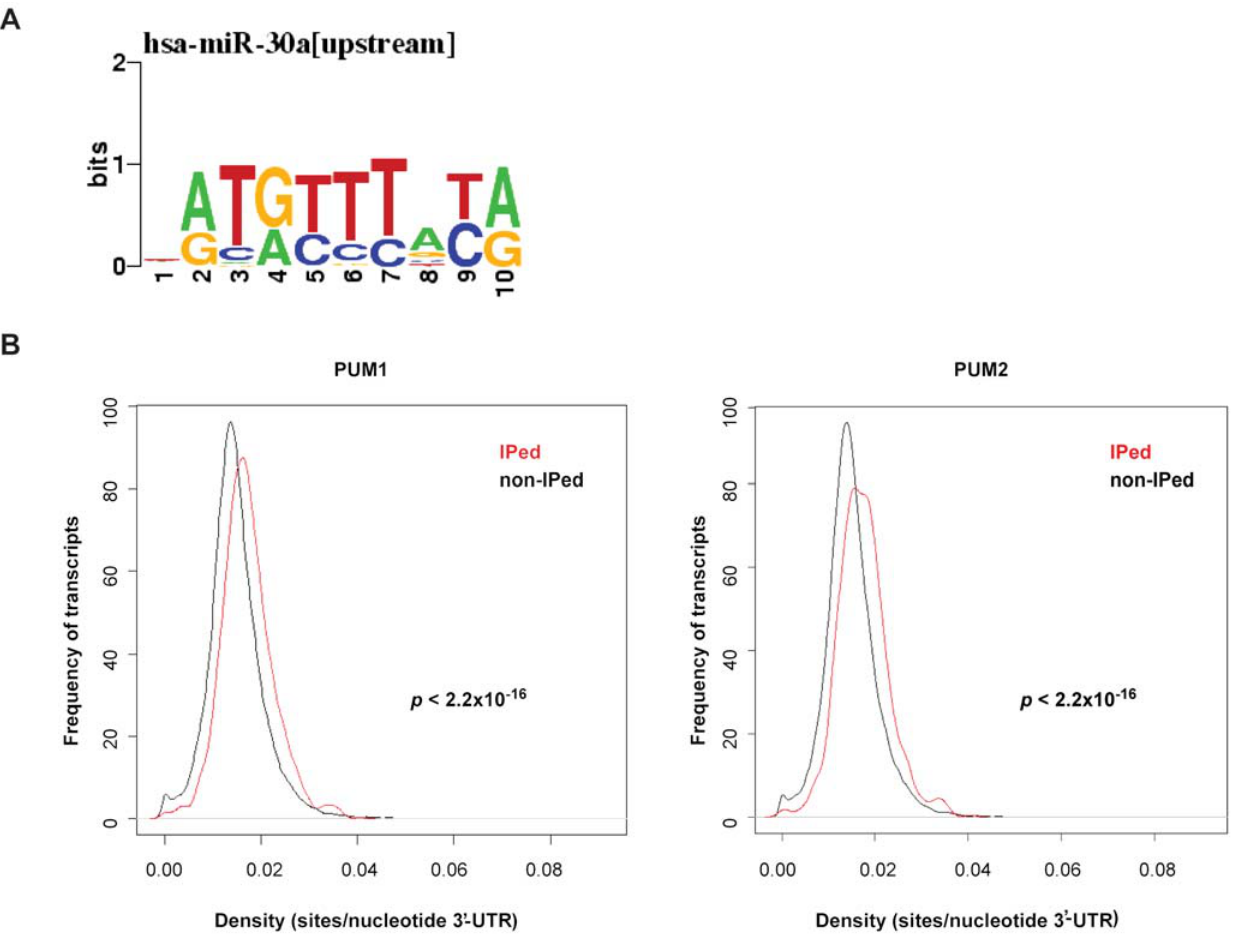
Figure 5. miRNA binding sites are enriched among human PUM targets. (A) Example of a motif identified using the Phylogibbs motif finding algorithm in the vicinity (400 nucleotides upstream) of high-confidence miR-30a target sites. The x-axis indicates the position of a nucleotide in the inferred motif, and the y-axis gives the information score (bits) at that position. The height of each letter is proportional to the frequency of the respective nucleotide at that particular position in the alignment of inferred sites. (B) Distribution of the density of high-confidence miRNA sites (sites per nucleotide of 3 9 -UTR) in the 3 9 UTRs of PUM targets (IPed, red) and non-targets (non-IPed, black).